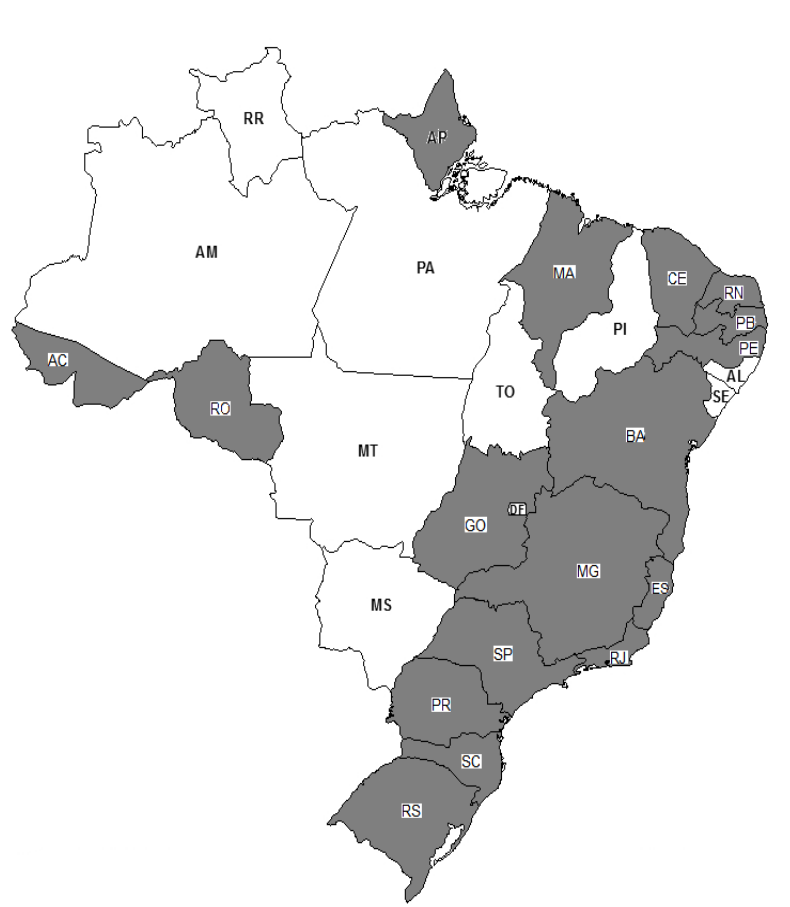
FIGURE 3 - States using Notivisa in a higher proportion than the national